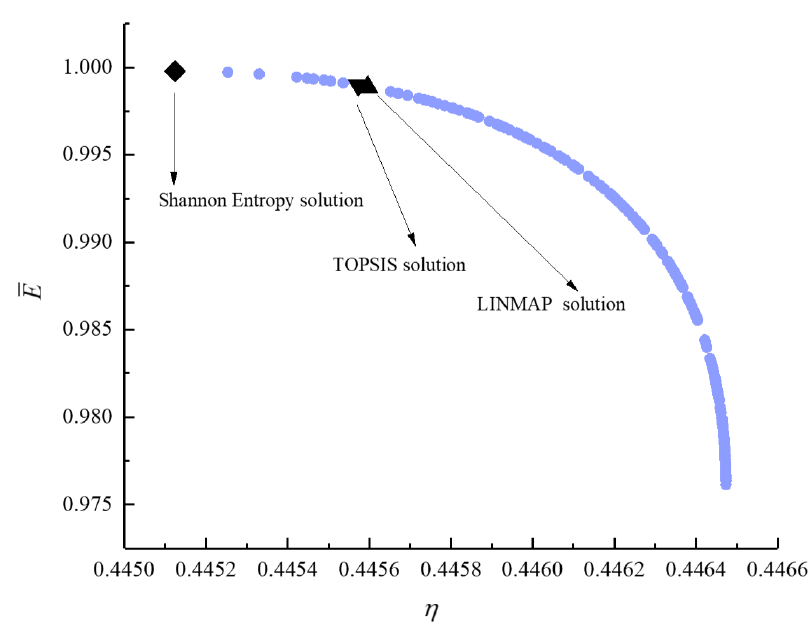
Figure 18. Bi-objective optimization on η − E .